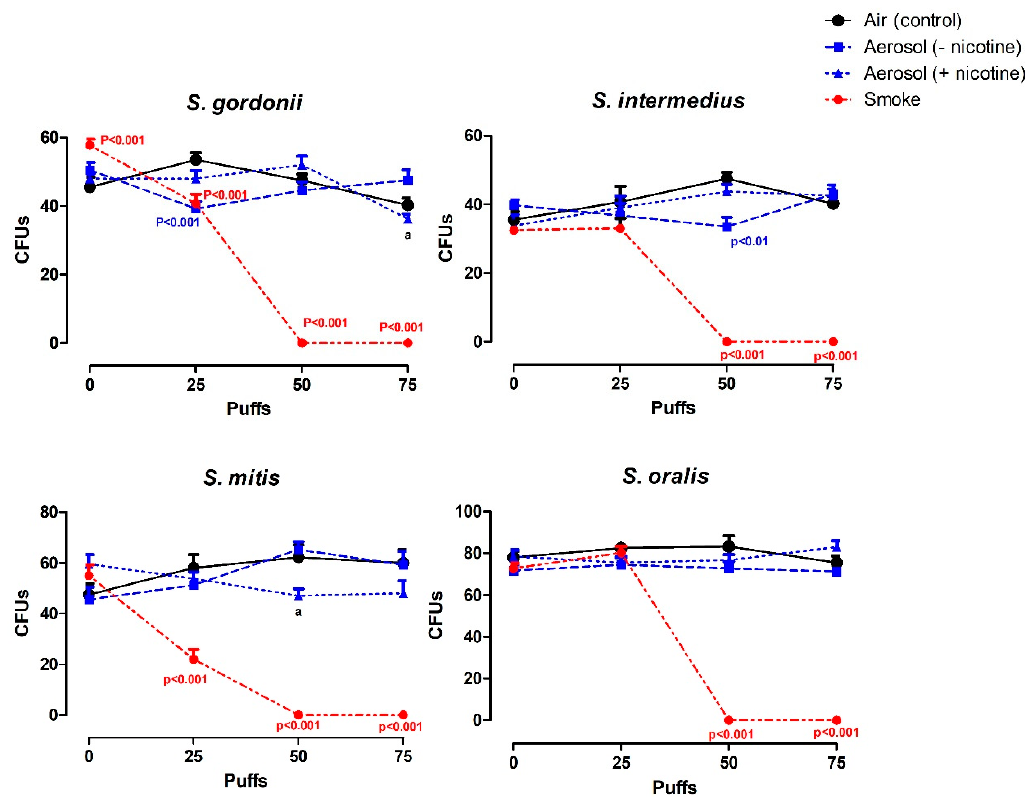
Figure 3. E ff ect of air, flavorless ECIG aerosol ( ± 20 mg / mL nicotine), or smoke (Marlboro ® Red cigarette) on colony-forming unit (CFU) counts. Each data point is Mean ± standard error (SE), n = 4 (average of triplicates from each quadrant of an agar plate), p values indicate significance from control. a = p < 0.01 between aerosol with nicotine and without nicotine.